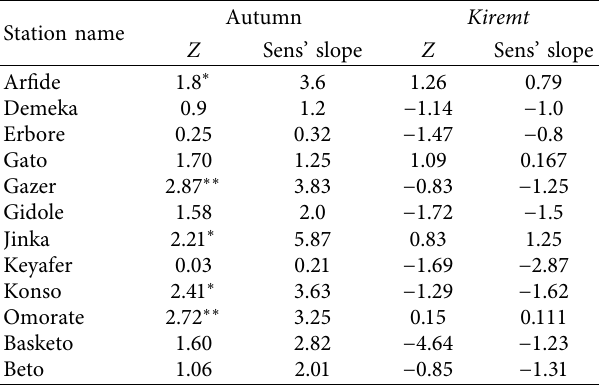
Table 4: Farmers’ perceptions of climate change over the thirty